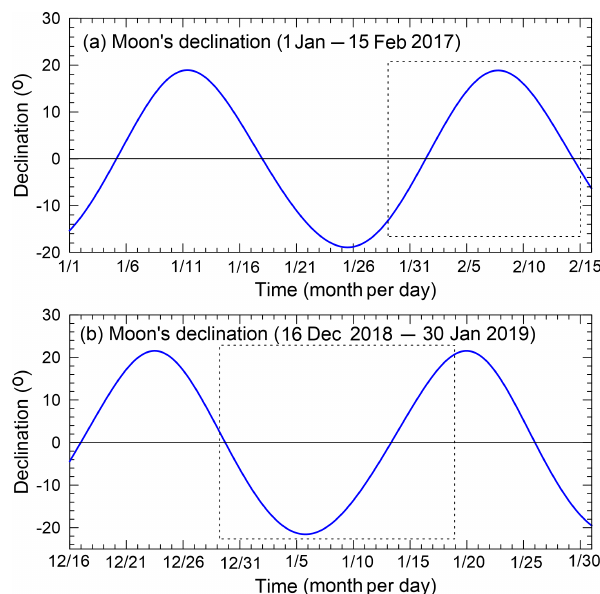
Figure 7. Time series of the Moon’s declination, calculated at daily intervals for two observation periods: (a) 1 January to 15 Febru- ary 2017; and (b) 16 December 2018 to 30 January 2019. Dashed boxes indicate the sea level observation windows examined in this